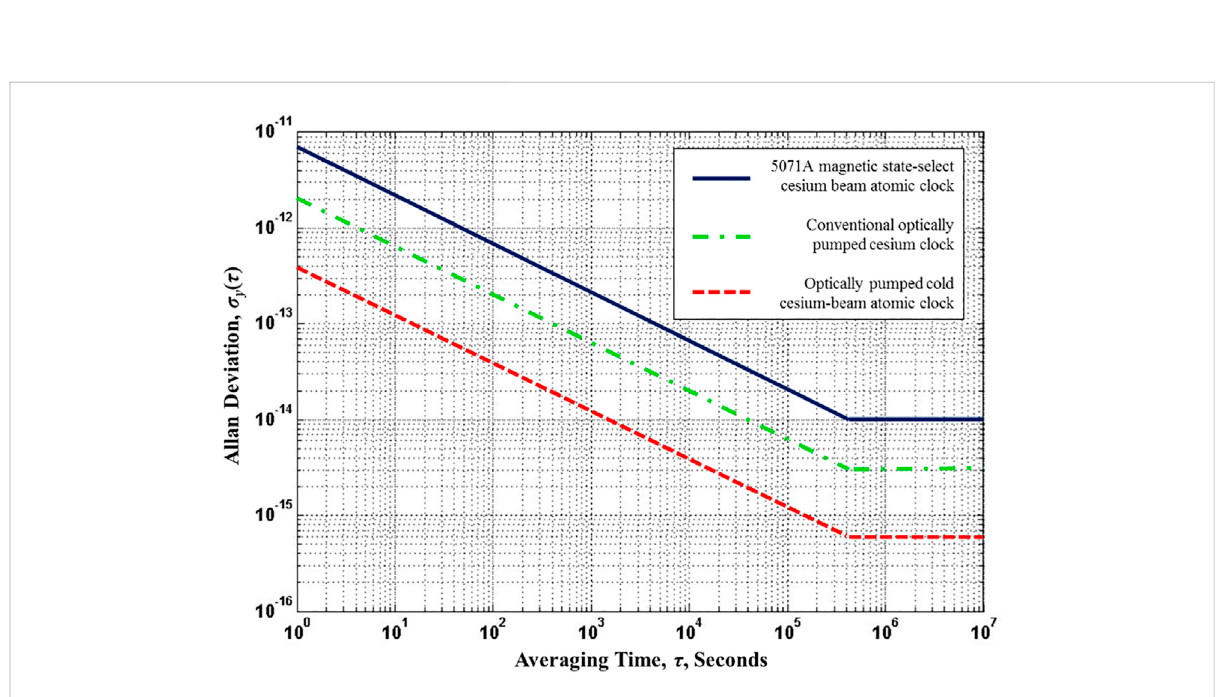
FIGURE 7 Comparison of the frequency stability of three atomic